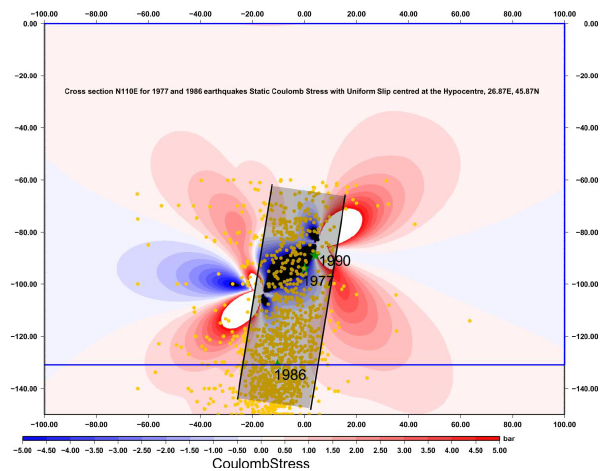
Fig. 6. Cross section of the Coulomb stress field due to 1977 earth- quake (depth=94km assuming an effective friction of 0.4). Strike of section is N104 ◦ E. Section centre point is the 1977 hypocentre. Colour palette of stress values is linear in the range of − 5 to + 5bar (1bar=100kPa). Blue areas indicate unloading, red areas indicate loading, respectively. White colour indicates area where transferred stress > 5bar and black colour the area where stress reduction was < − 5bar. Green stars show the earthquake hypocentres. Blue line at 131km depth shows the map view of Fig. 2a. Solid yellow circles are aftershocks (1977–1986). Shaded rectangle indicates shape of Vrancea slab (dip to the West).